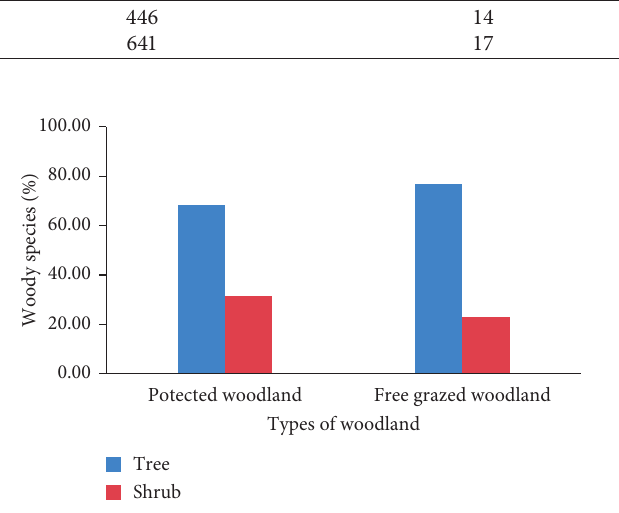
Figure 2: Floristic composition of protected and free grazed woodland. Table 2: Mean diversity indices and richness of woody species in protected and free grazed woodland.